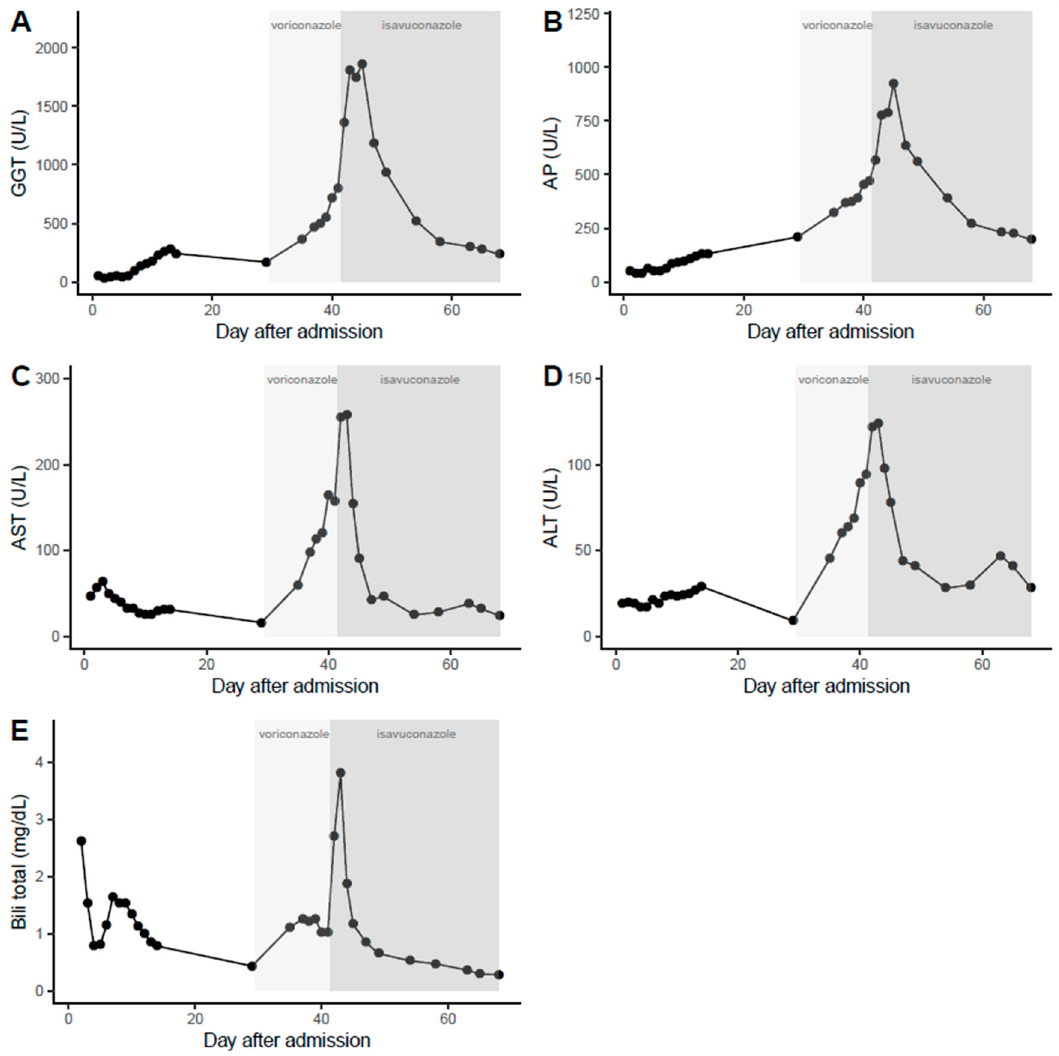
Figure A1. ( A ) Gamma-glutamyl transferase (GGT) levels in function of the time after hospital ad- mission; ( B ) Alkaline phosphatase (AP) levels in function of the time after hospital admission; ( C ) Aspartate aminotransferase (AST) levels in function of the time after hospital admission; ( D ) Ala- nine aminotransferase (ALT) levels in function of the time after hospital admission; ( E ) Total biliru- bin (bili total) levels in function of the time after hospital